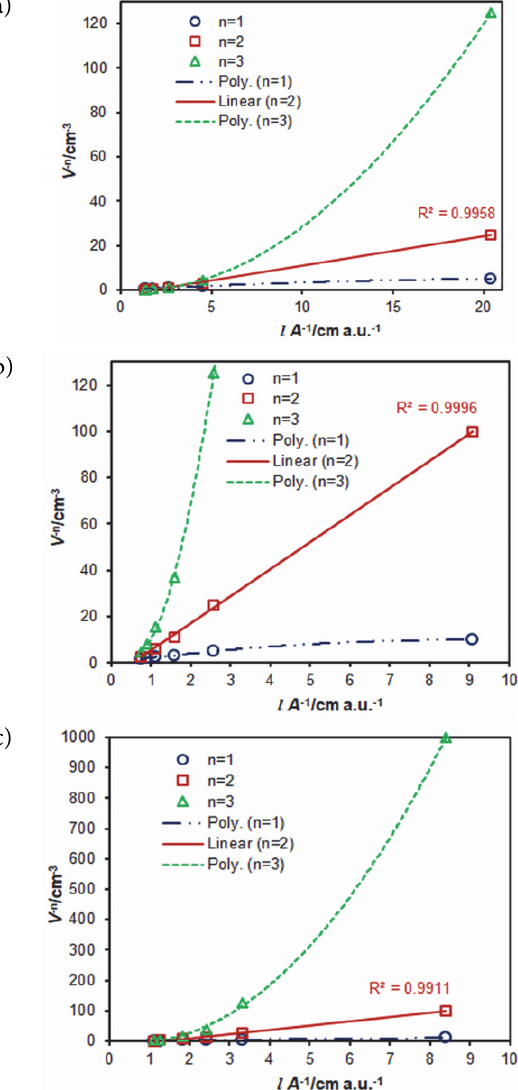
Figure 5. Determination of the MTAR-to-Co molar ratio by the straight-line method of Asmus. The experimental conditions are given in Figure 4, curves 1a-c, respectively.